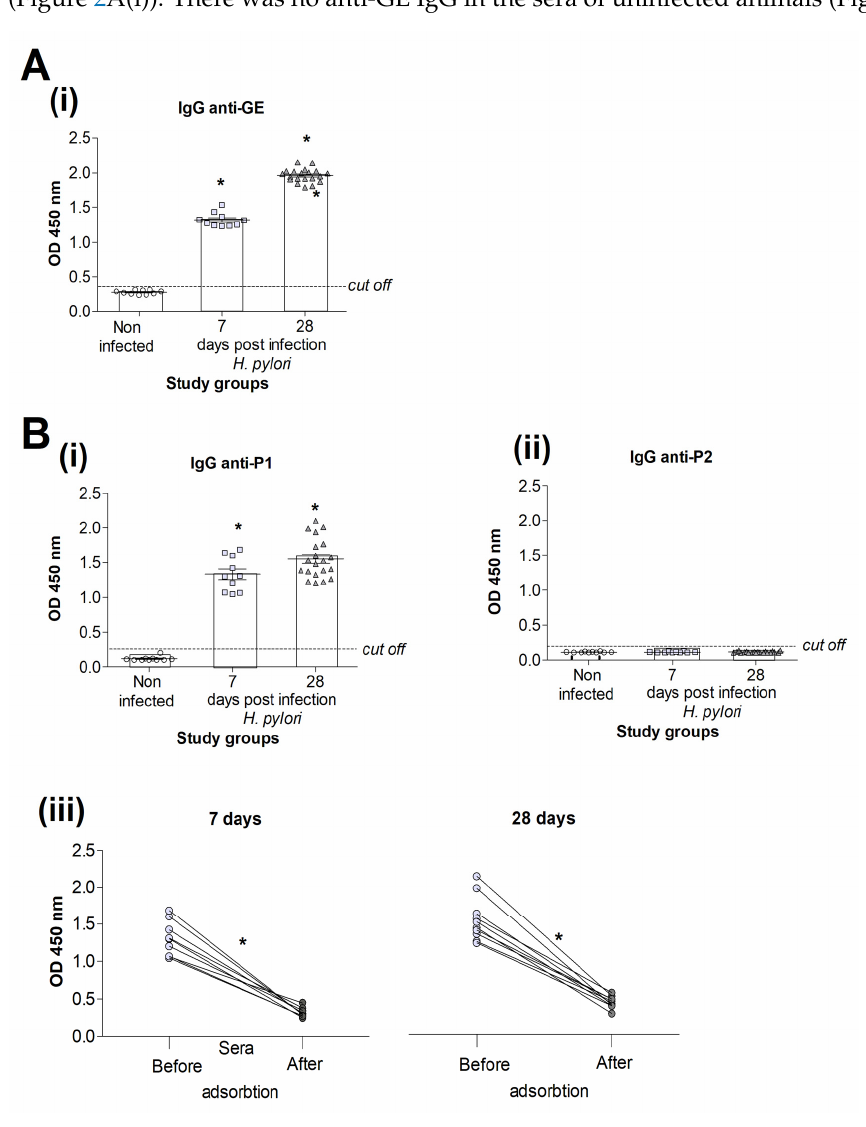
Figure 2. The prevalence and the level of antibody production in Caviae porcellus model. In Caviae porcellus infected experimentally with H. pylori, the enzyme-linked immunosorbent assay (ELISA) was used to examine serum samples for anti-GE IgG ( Ai ) and anti-P1/P2 IgG ( Bi , Bii ). Anti-P1 antibodies in serum samples of H. pylori infected animals, 7 and 28 days from inoculation, non-adsorbed or adsorbed with these bacteria ( Biii ). Sera were collected from control animals noninfected with H. pylori , n = 10, and from animals infected with H. pylori , 7 days, n = 10 or 28 days, n = 20, after the last inoculation with H. pylori . Shown are mean values ± standard deviation (SD). P1, synthetic peptide with the amino acid sequence (TVLLPLVIFF) of Caviae porcellus tumor necrosis factor receptor (TNFR); P2, control synthetic peptide (IAKEGFEKIS). GE, glycine acid extract from the reference H. pylori strain. The dot, square or triangle in the figure represent an individual data. Statistical significance: sera from Caviae porcellus infected with H. pylori vs. sera from non-infected animals ( Ai , Bi , Biii ) sera before and after adsorption * p <